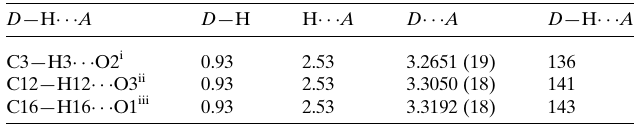
Table 1 Hydrogen-bond geometry (A˚ , (cid:2)